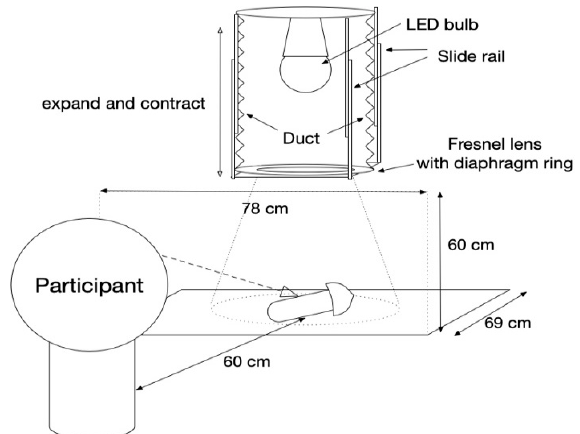
Figure 1. Arrangement of the experimental booth with a light emitting diode (LED) lighting system, and a stimulus.